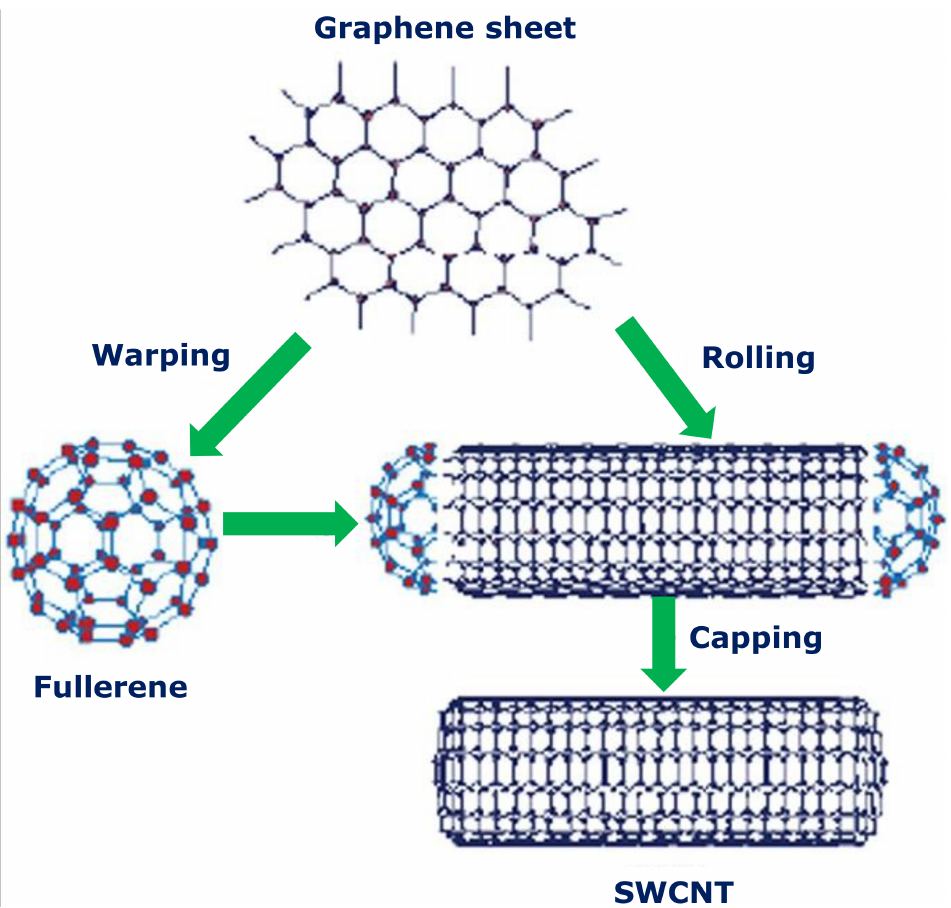
Figure 4. Preparation method of end-capped single single-walled carbon nanotubes (SWCNTs)